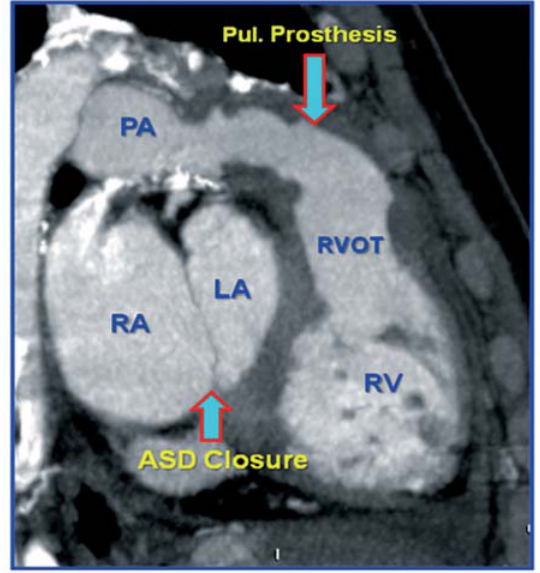
Fig. 6 - Postoperative CT angiography with contrast showing: reconstruction of the right ventricle outlet tract (RVOT) with pulmonary prosthesis. PA = pulmonary artery; RV = right ventricle; LA = left atrium; RA = right atrium; ASD = atrial septal